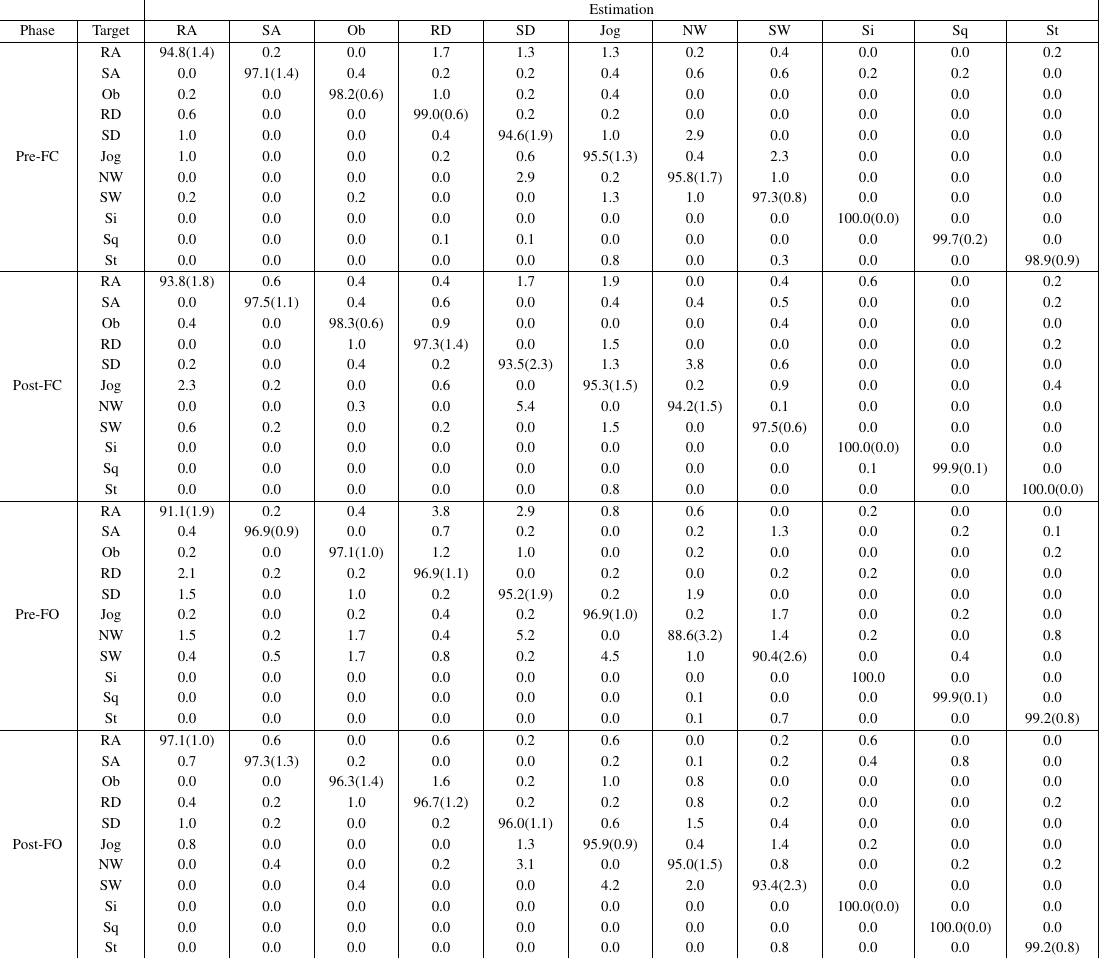
Table 2. Confusion matrix (mean (standard error of the mean)) for twelve subjects (%). RA, ascending a ramp; SA, ascending stairs; Ob, climbing obstacles; RD, descending a ramp; SD, descending stairs; Jog, jogging in place; NW, normal walking; SW, side walking; Si, sitting; Sq, squatting; St,